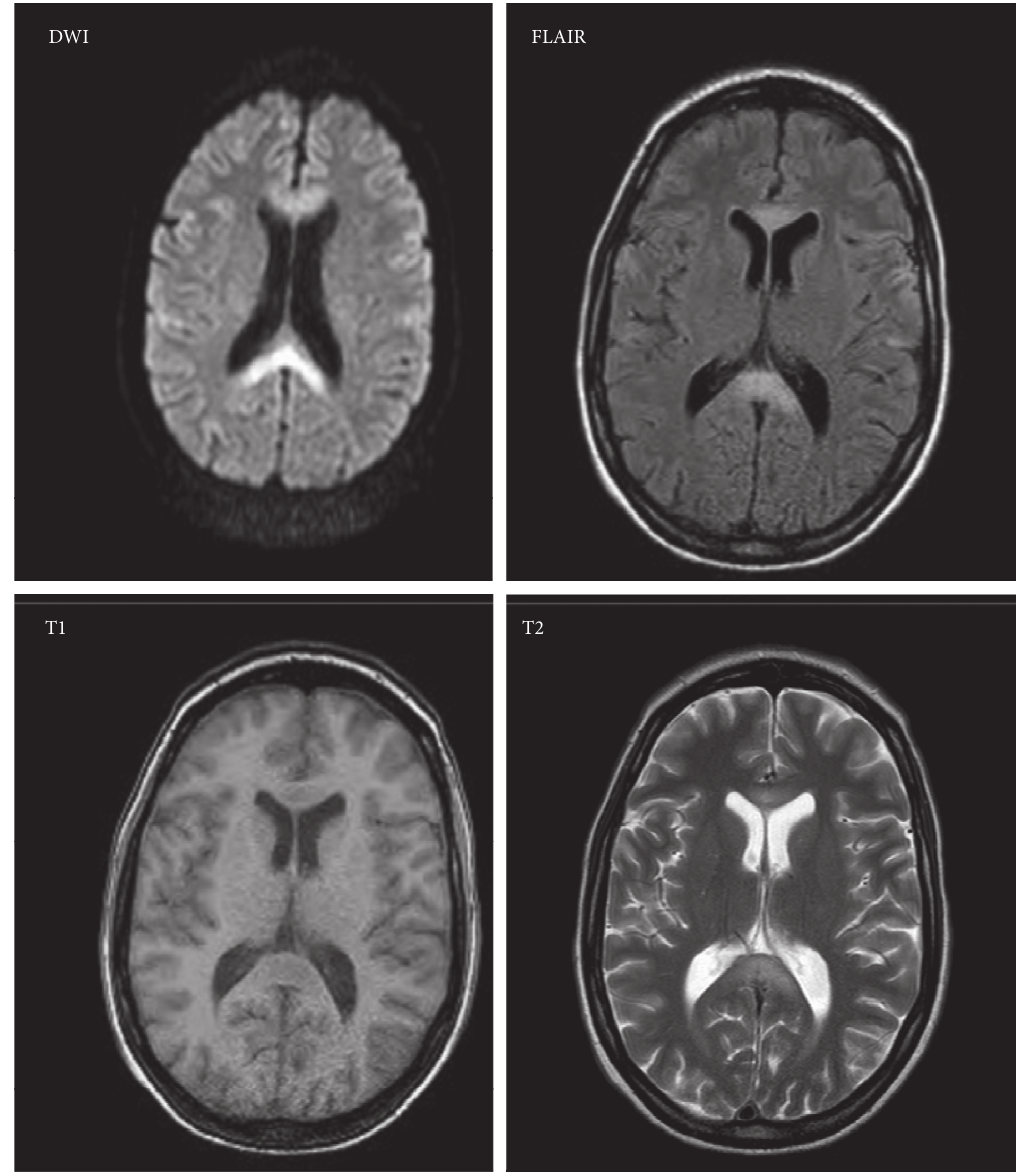
Figure 1: An MRI of the brain with a diffusion-weighted imaging (DWI) sequence showing restricted diffusion in the genu and splenium of the corpus callosum. A T1-weighted sequence shows hypointensity in the genu and splenium with corresponding hyperintensity on T2- weighted and T2-weighted fluid-attenuated inversion recovery (T2-FLAIR) images T2 and FLAIR. There is no enhancement noted with gadolinium (not